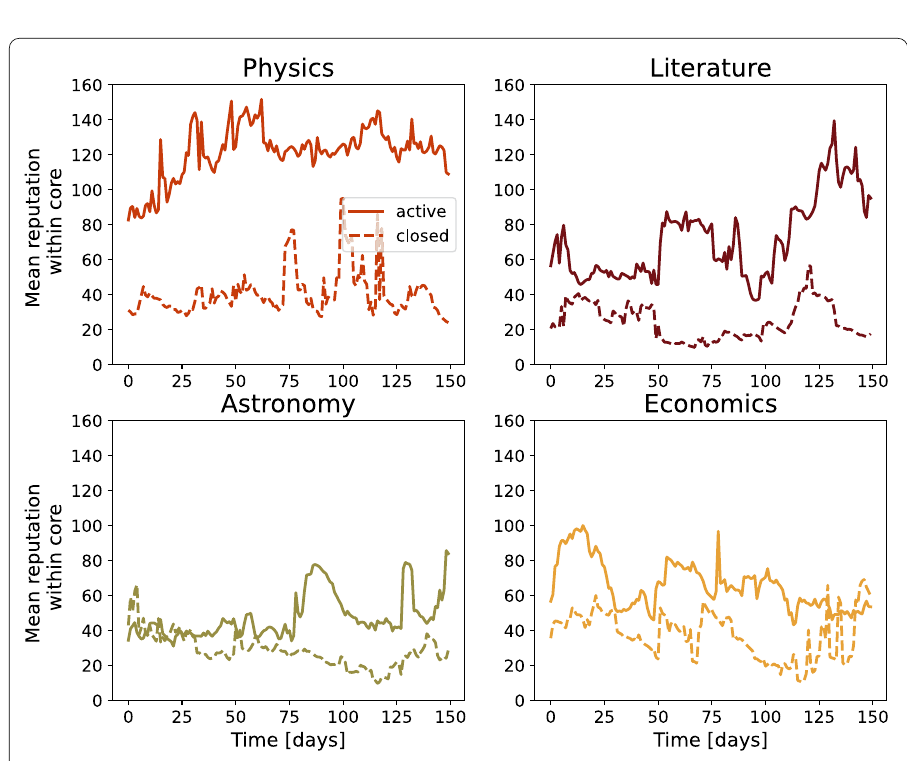
Figure 6 Mean Dynamical reputation within the core for four pairs of Stack Exchange websites: Astronomy, Literature, Economics, and Physics. Solid lines – active sites; dashed lines – closed